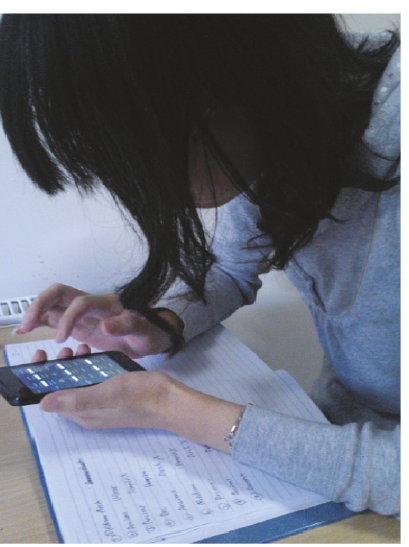
Figure 3: Experimental setting.